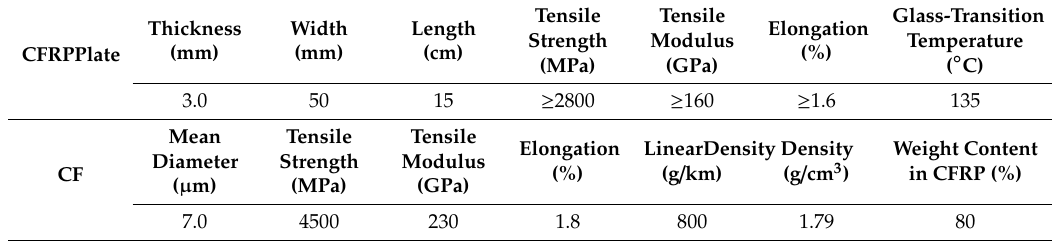
Table 1. Information of the initial carbon-fiber-reinforced plastics (CFRPs) and